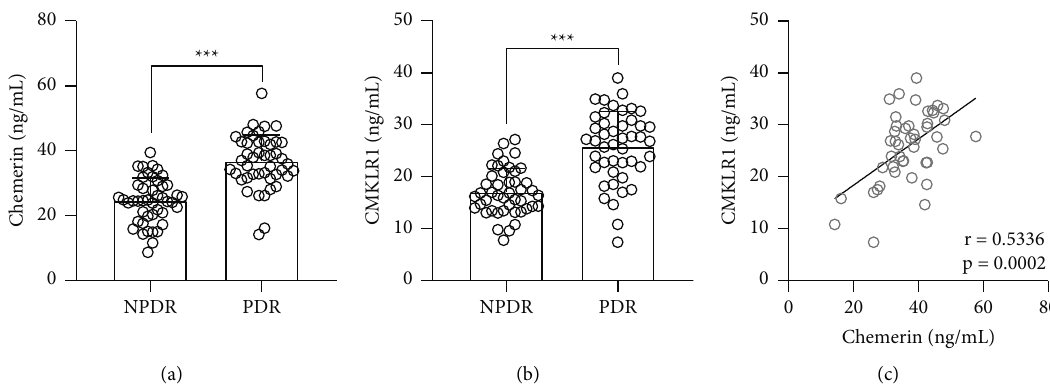
Figure 1: Comparisons of serum chemerin (a) and CMKLR1 (b) between NPDR and PDR patients. N � 45 for each group. Unpaired t -test. (c). Pearson correlation coefficient of serum chemerin and CMKLR1 in PDR patients.